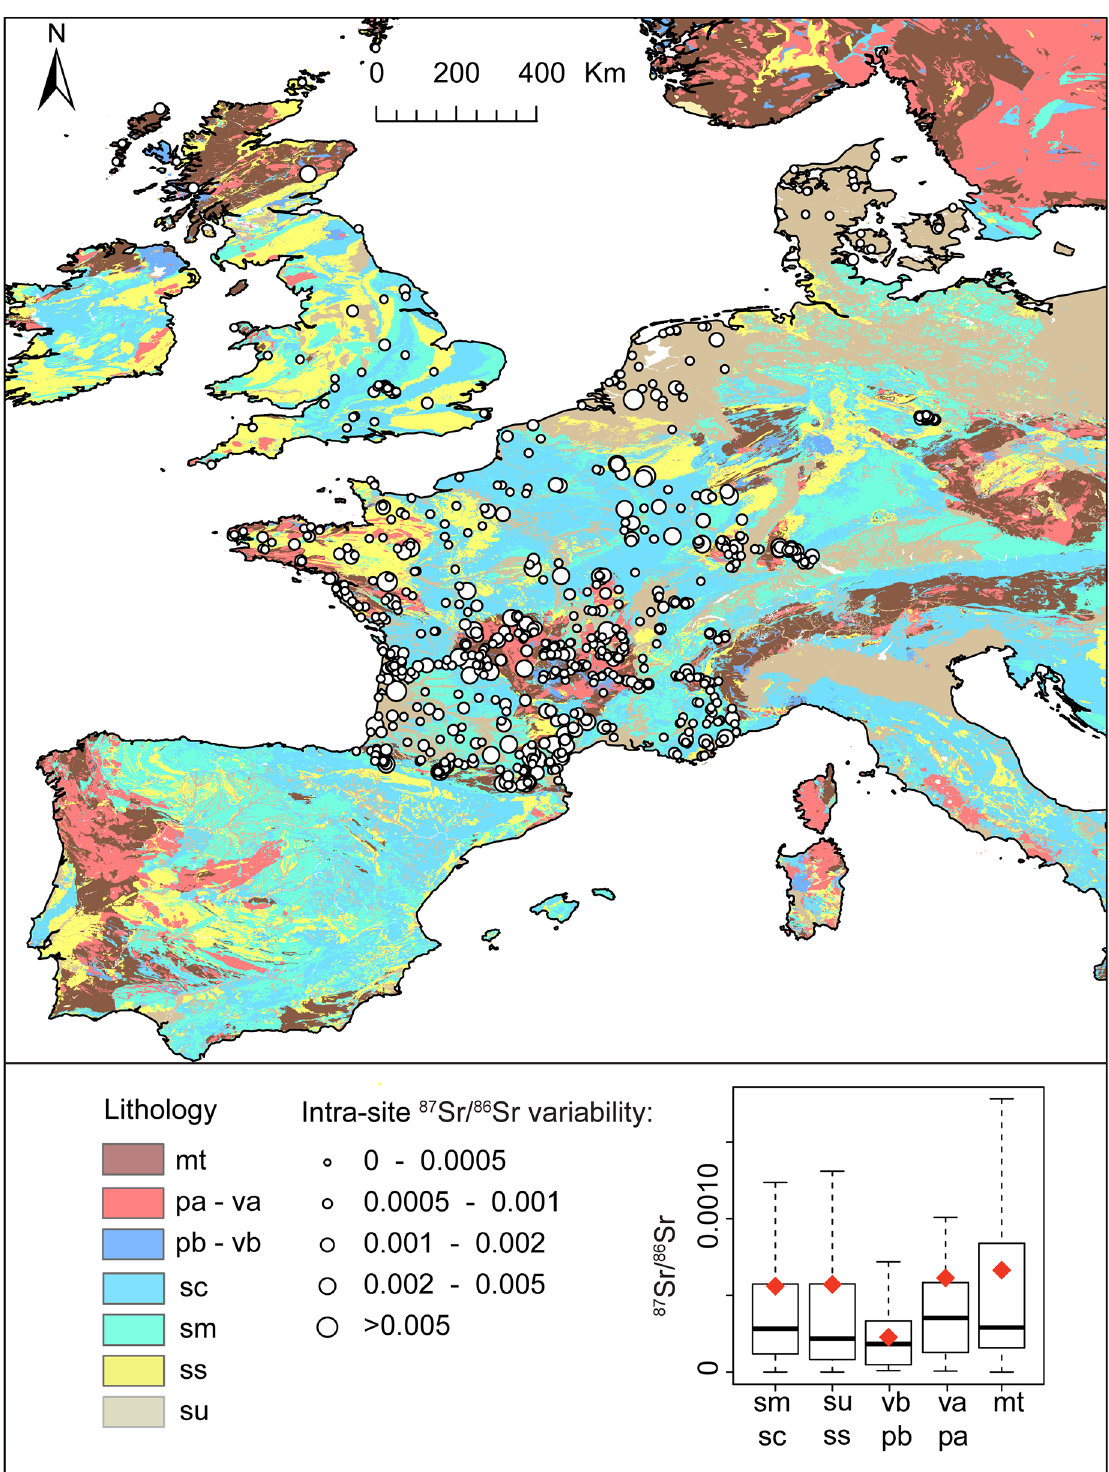
Fig 3. Within-population 87 Sr/ 86 Sr uncertainty visualization. Bubble map of the standard deviation of 87 Sr/ 86 Sr analyses of different substrates from the same site plotted over the lithological map of Western Europe from the GLiM database. A boxplot in the bottom-right corner shows the variability of 87 Sr/ 86 Sr ratios by geological group with the thick black line representing the median value, the box representing the quartiles and the tails representing minimum and maximum value. We added the mean value as a red diamond for